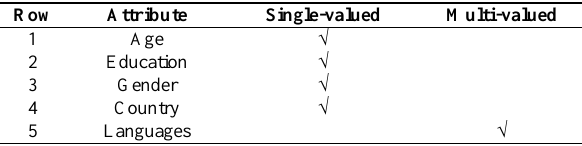
Table 1. Details of vertex attributes of generated graph.